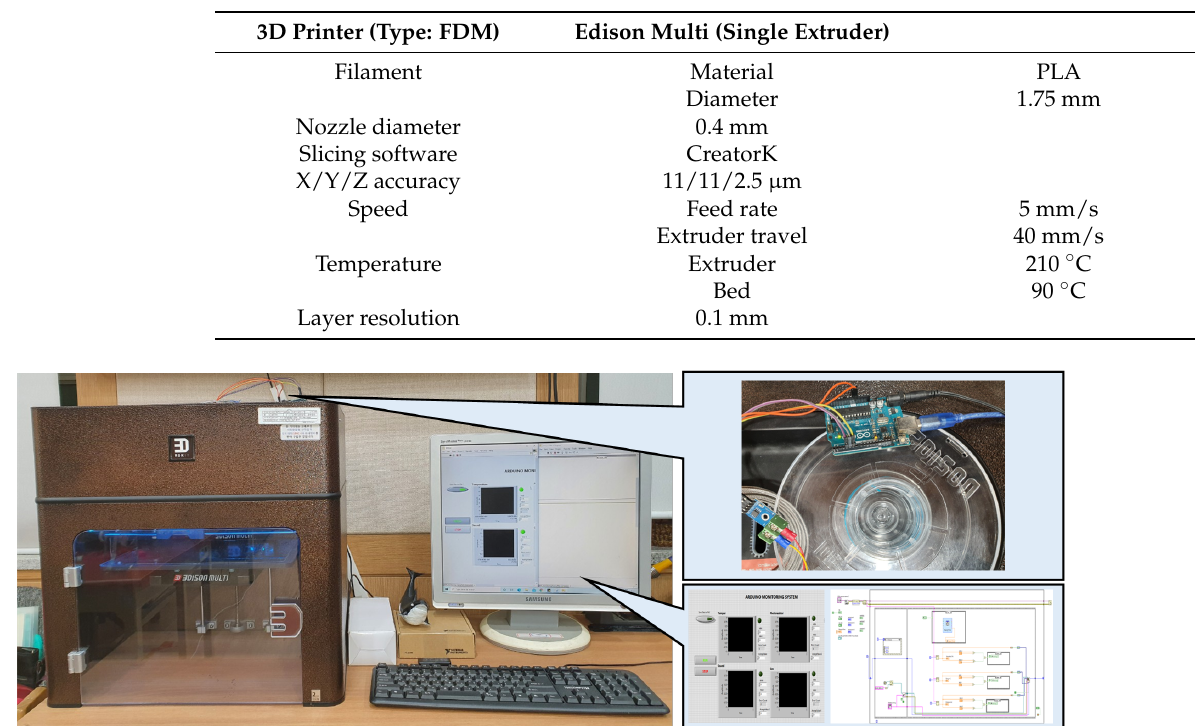
Table 1. 3D Printer Experimental conditions.